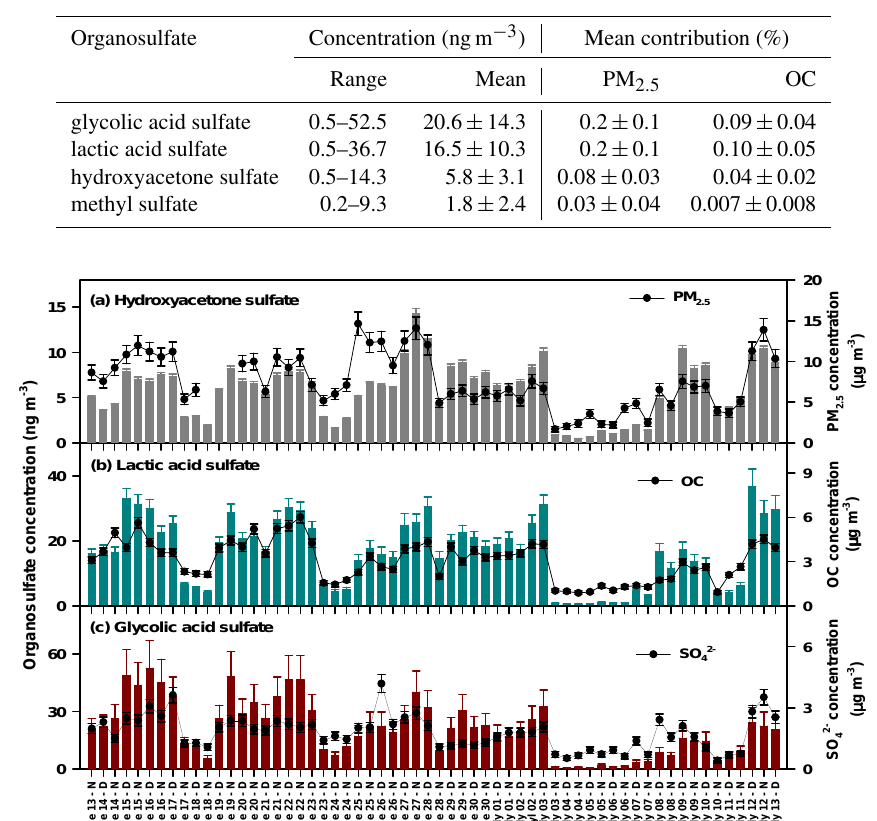
Figure 1. Concentrations of glycolic acid sulfate, lactic acid sulfate, and hydroxyacetone sulfate quantified against authentic standards, and ) measured at Centreville, AL, during SOAS from 13 June to 13 July 2013 on the basis PM 2 . 5 , organic carbon (OC), and sulfate (SO 2 − 4